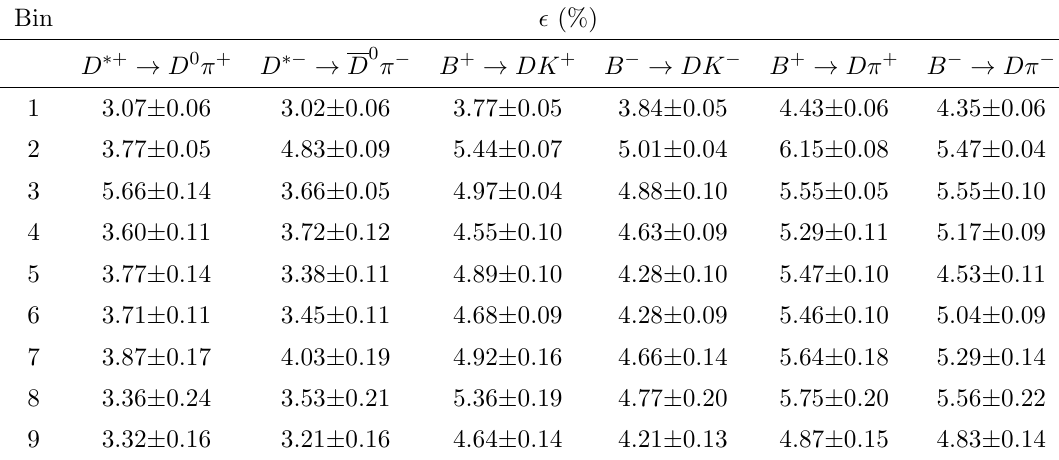
Table 11 . E(cid:14)ciency in each bin of the D phase space for D (cid:3)(cid:6) ! D(cid:25) (cid:6) , B (cid:6) ! DK (cid:6) , and B (cid:6) ! D(cid:25) (cid:6) decays determined from the corresponding signal MC samples.